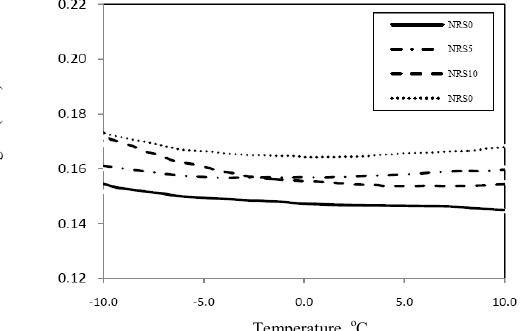
Figure 13. Range of temperature that criterion for measuring rolling resistance of samples at various silica ratios.